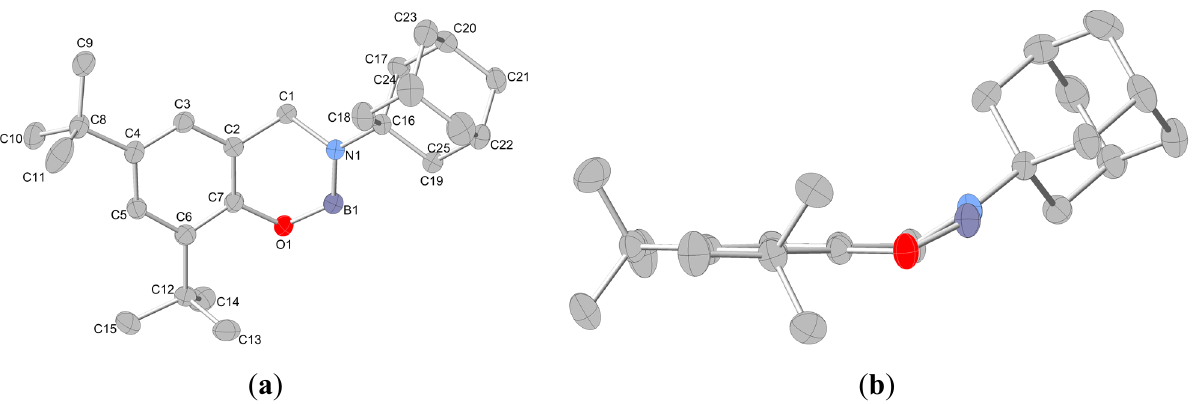
Figure 3. Two views of the molecular structure of 1b with ellipsoids drawn at 50% probability level with hydrogen atoms omitted for clarity. Selected bond distances (Å) and angles (°) for 1b : B(1)–N(1) 1.3944(17), B(1)–O(1) 1.3953(16), N(1)–C(1) 1.4753(15), N(1)–C(16) 1.4829(15), O(1)–C(7) 1.3848(14), C(1)–C(2) 1.5051(16); N(1)–B(1)–O(1) 120.90(11), B(1)–N(1)–C(1) 116.80(10), B(1)–N(1)–C(16) 126.88(10), C(1)–N(1)–C(16) 116.32(9), C(7)–O(1)–B(1) 118.97(9), N(1)–C(1)–C(2)